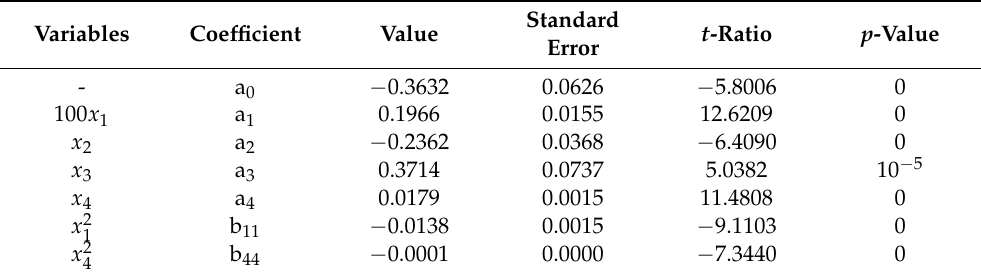
Table 3. Summary of regression coefficients for P h